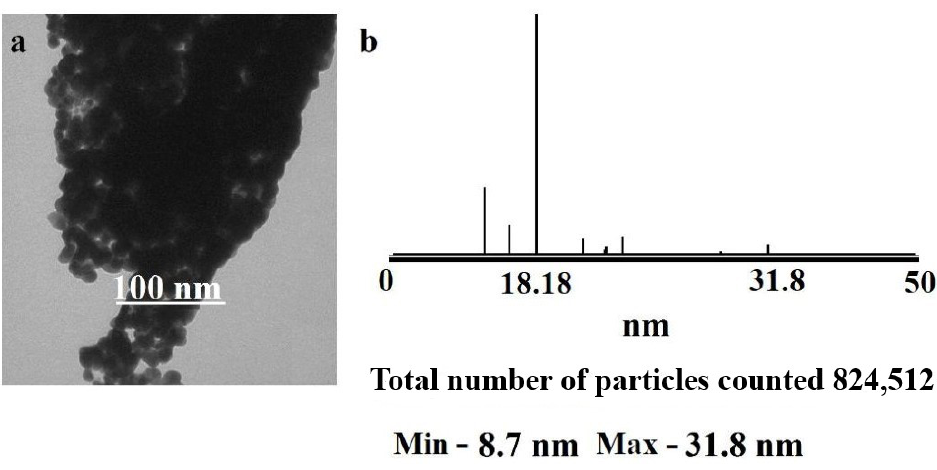
Figure 15. ( a ) TEM image of the thermolysis product of silver maleate in xylene; ( b ) histogram illustrating the particle size distribution in the thermolysis product of silver maleate in xylene.